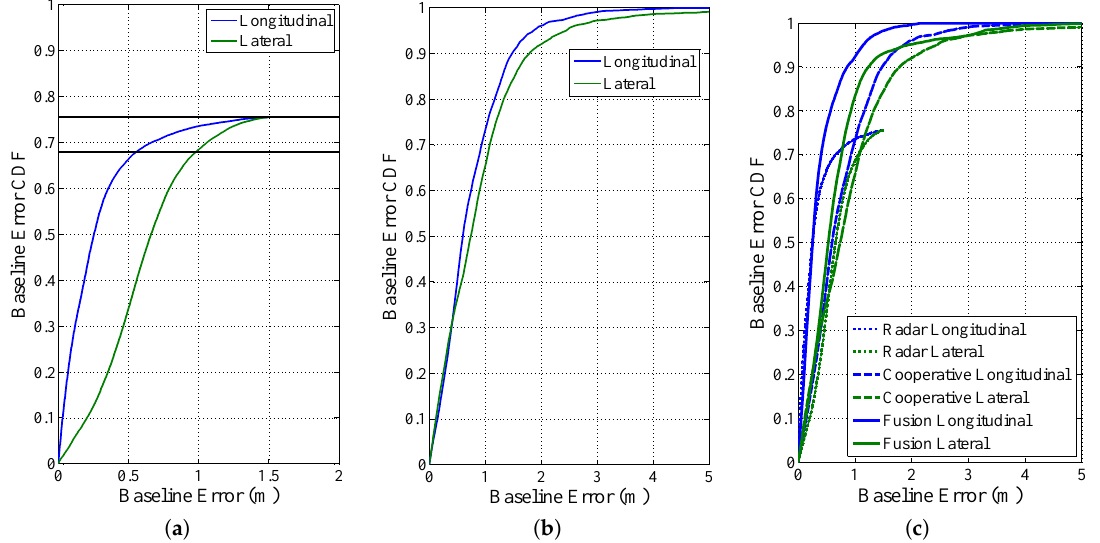
Figure 5. The figures show the relative positioning error in longitudinal (blue) and lateral (green) direction for a radar sensor ( a ), a cooperative approach ( b ) and the fusion of both ( c ) while driving on a highway [114]. The radar sensor has a good longitudinal accuracy, but a limited availability of 75%. The cooperative approach has a larger error, similar in both directions and continuous availability. The continuous lines in ( c ) show the fusion of both, where an increased precision and availability are